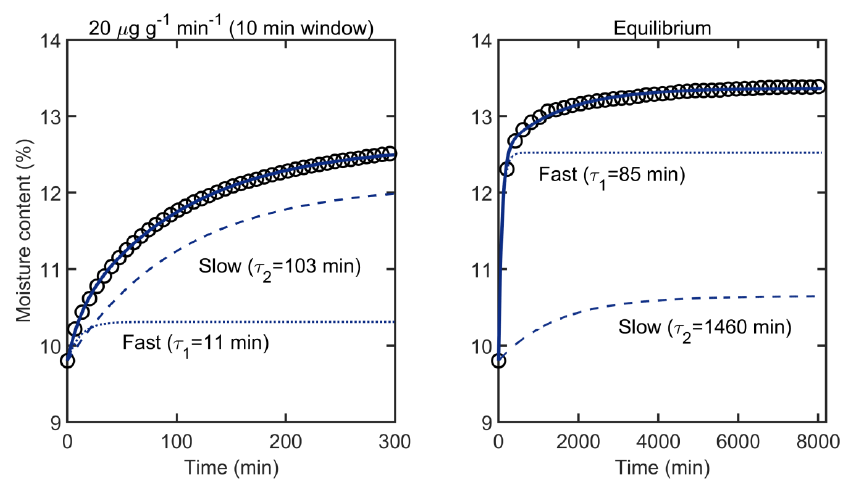
Figure 8. Parallel exponential kinetics (PEK) model fitted to sorption curve of Figure 1. The model partitions the moisture change into “fast” and “slow” moisture components, each with a characteristic time constant. Sorption data and model fits are shown for interrupted sorption (left) based on the common mass stability criterion of 20 µ g g − 1 min − 1 and for sorption until equilibrium (right). For clarity, the left plot shows only every 5 th data point and the right plot only every 150th data point. Data from [139].